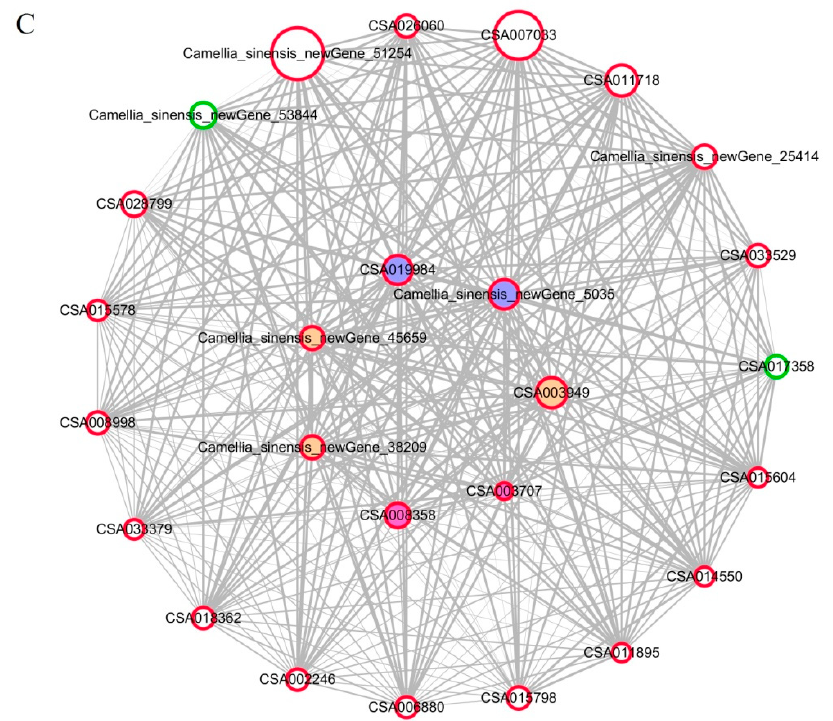
Figure 6. WGCNA of gene expressions and the related traits. ( A ) Hierarchical clustering tree showing co-expression modules. Genes within the same color-coded module represent a group of genes with similar expression patterns. ( B ) Module-trait relationship. The cells in Figure 6A were assigned a color based on their statistical significance and labeled with two numbers; the lower number indicates the p-value and the upper number indicates the correlation coefficient. The size of node circle is positively correlated with the number of the interacting genes. ( C ) Correlation networks of hub genes in the brown and purple module.